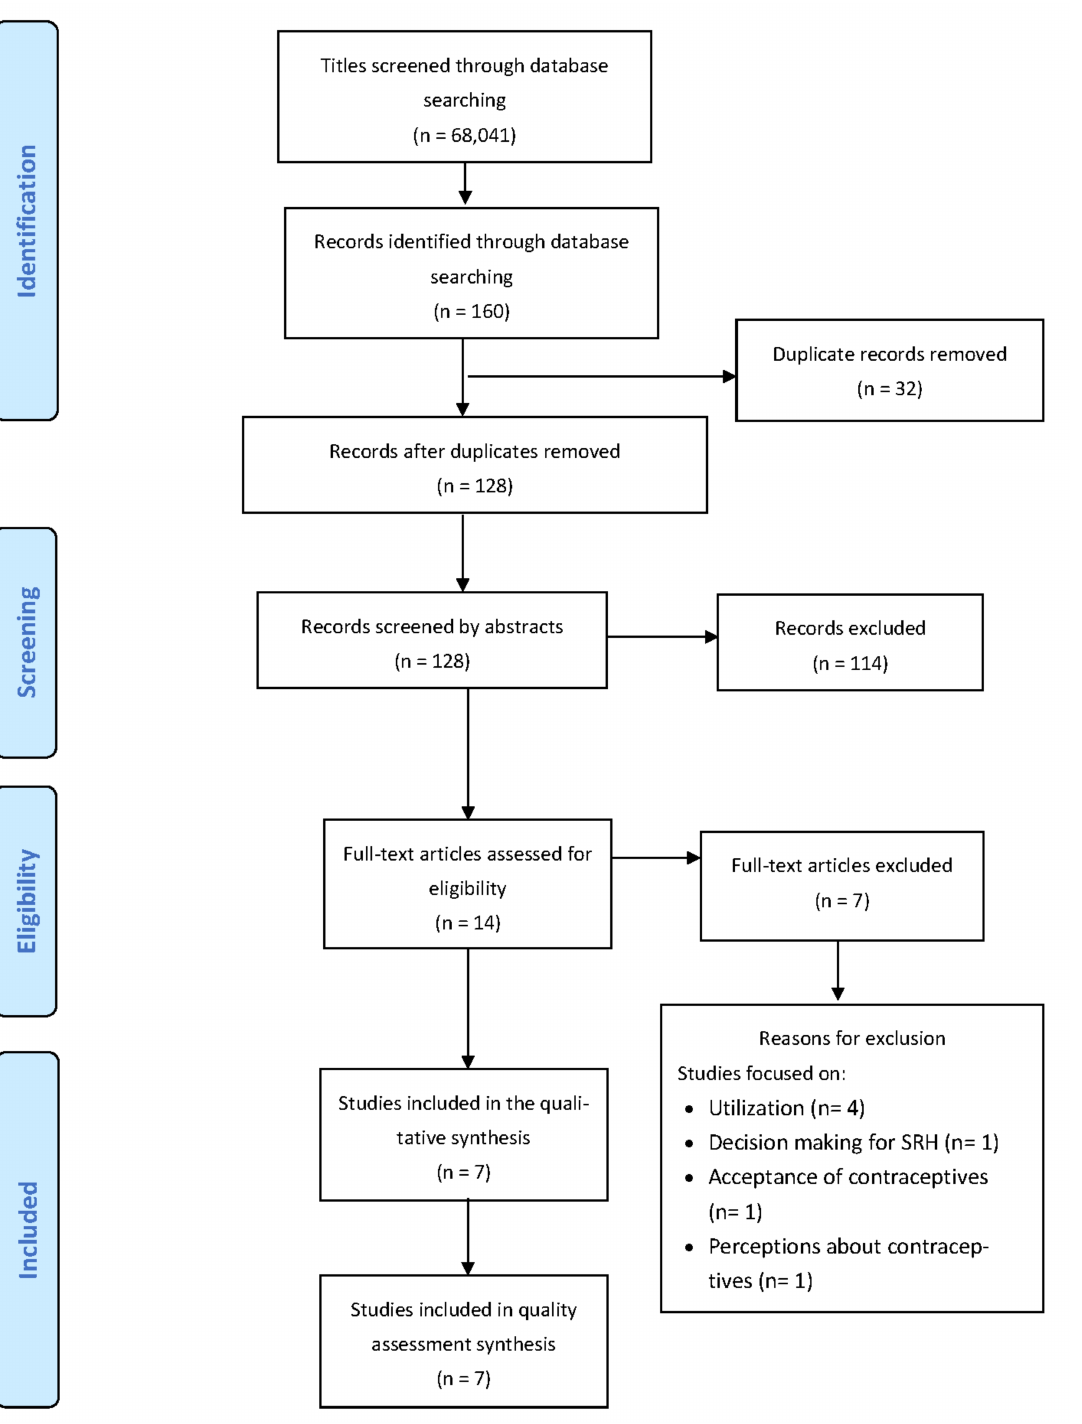
Figure 1. PRISMA 2009 flow